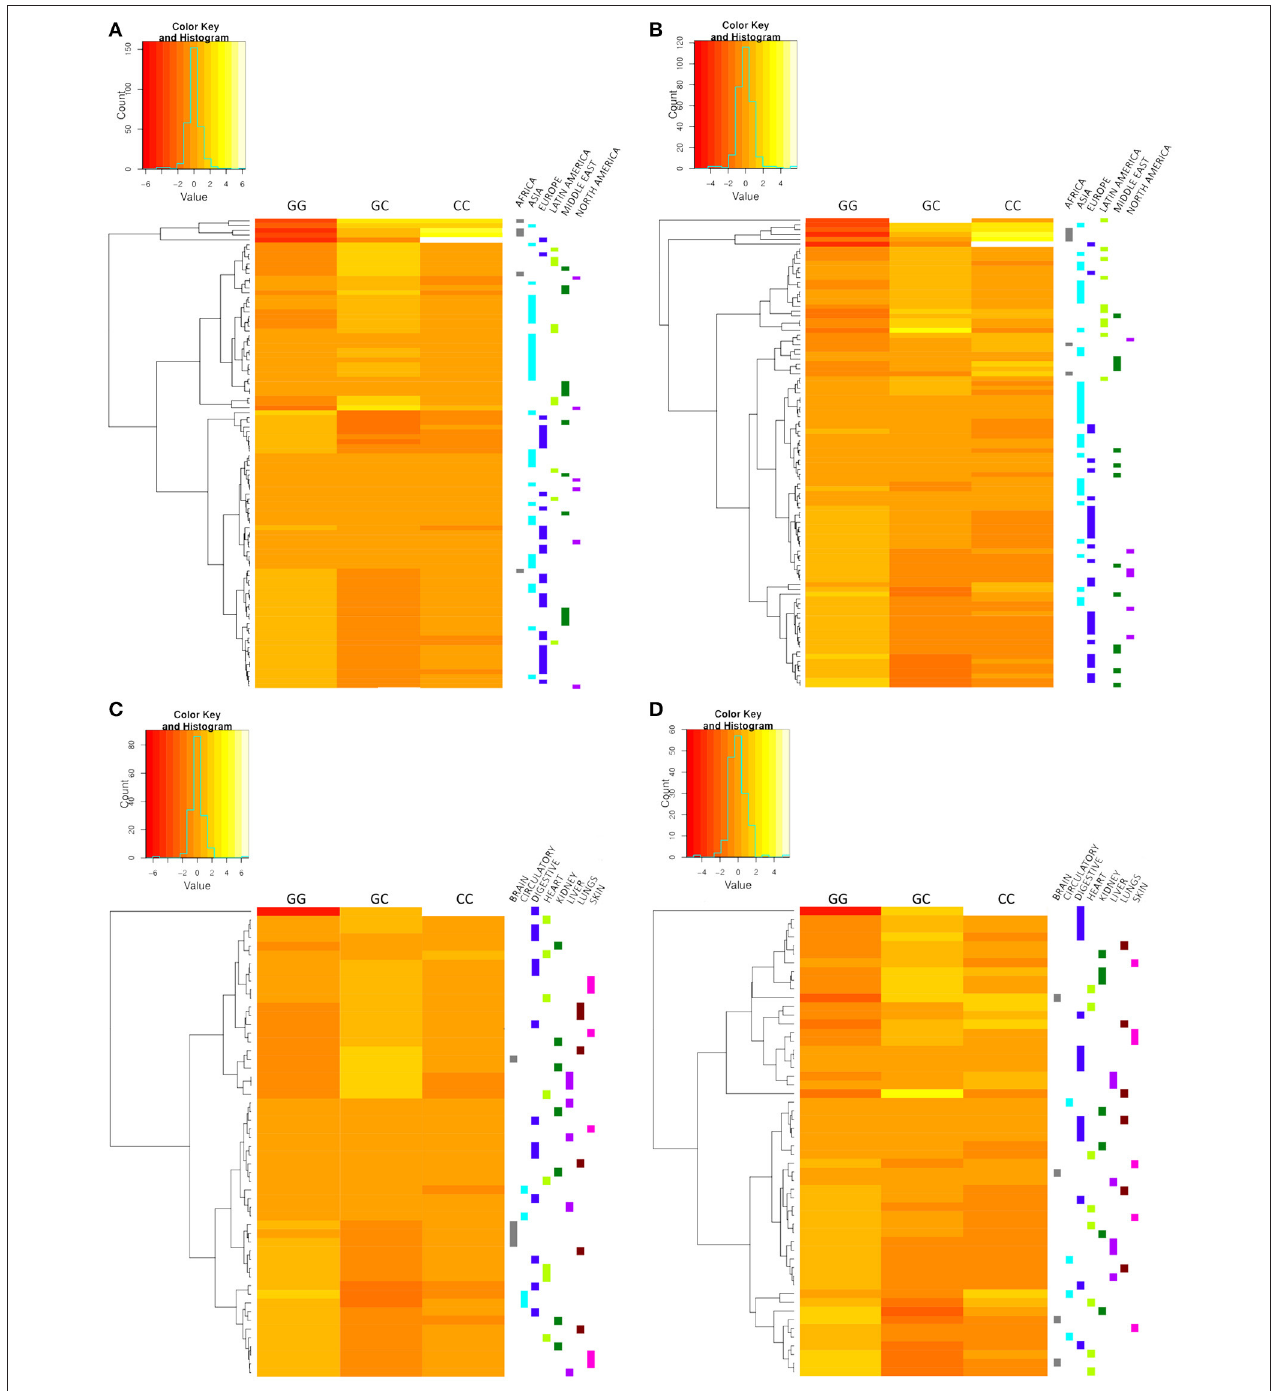
FIGURE 2 | Hierarchical clustering heat-maps. Geographic localization setting controls (A) and patients (B) . Disease physiological localization setting controls (C) and patients (D) . The corresponding subdivision of each study is indicated on the right side of the heat-map, and each color represents a different subdivision. Cohorts of the European, Latin American, African, and North American subdivisions show a tendency to group together. No clear grouping was observed for the disease physiological localization setting.